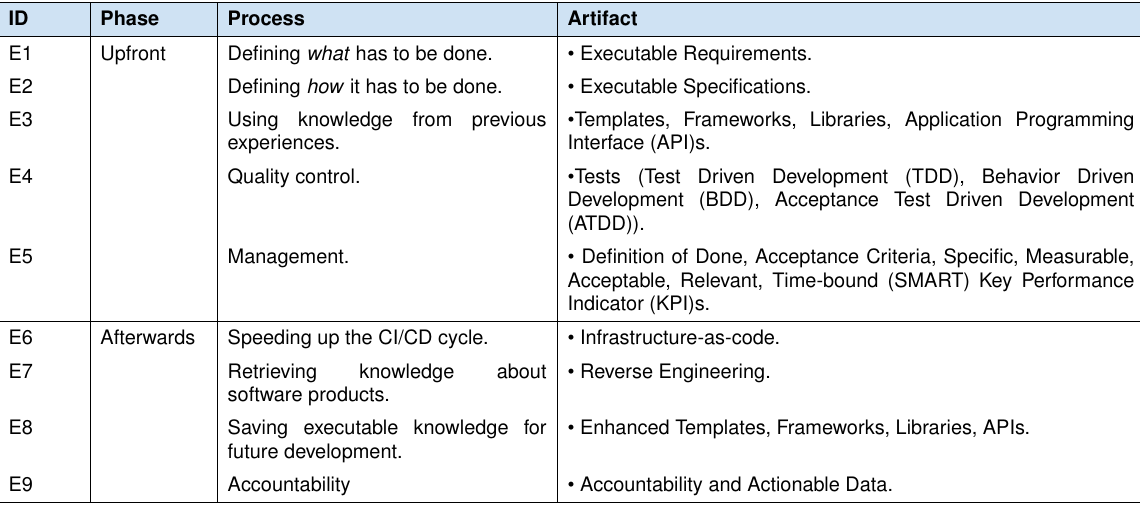
Table 2. Phases, Processes, and Artifacts in Continuous Software Development. All artifacts refer to executable